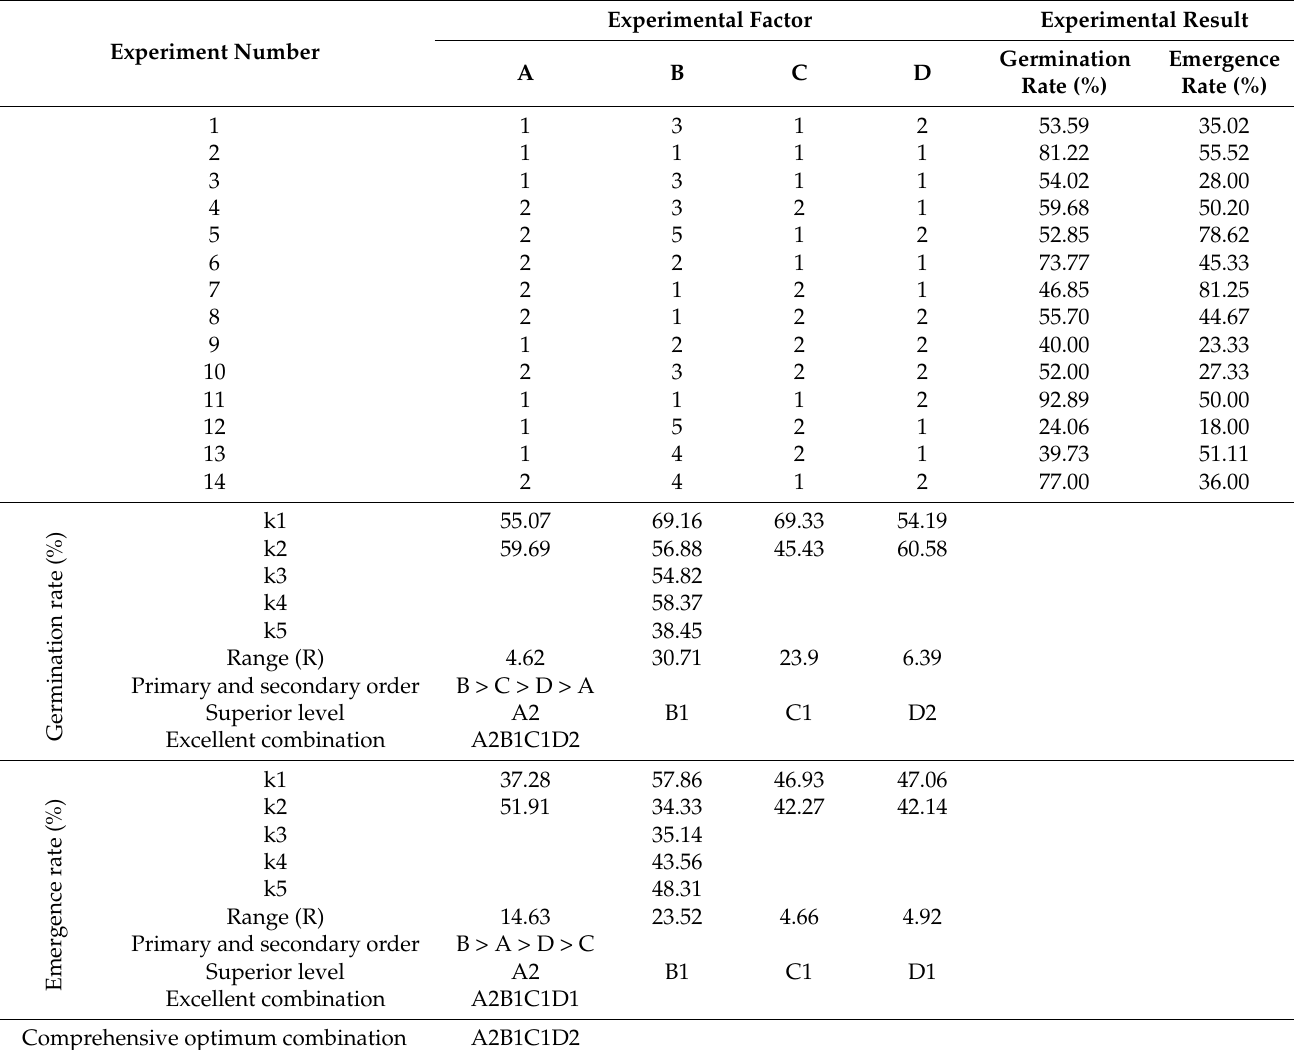
Table 4. Orthogonal experimental design and optimum results of Dunkelfelder grape